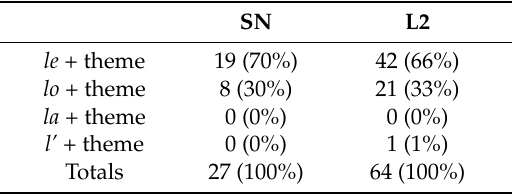
Table 8. Clitics according to thematic role